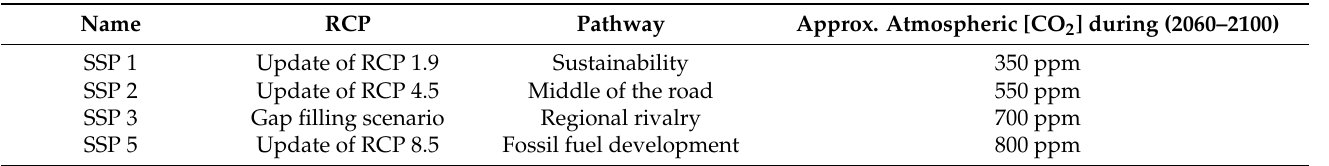
Table 3. SSP scenarios considered in the